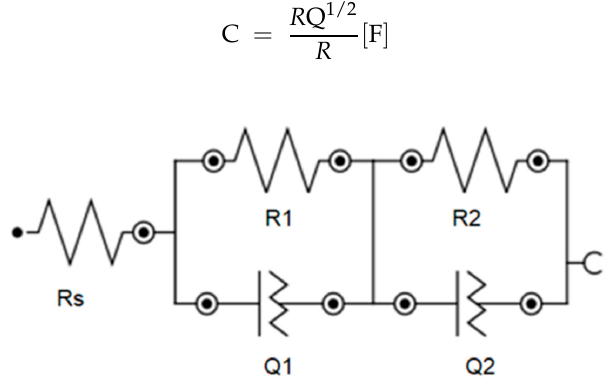
Figure 4. Equivalent circuit used to model the impedance spectra of the TNTs and AuNPs/TNTs.